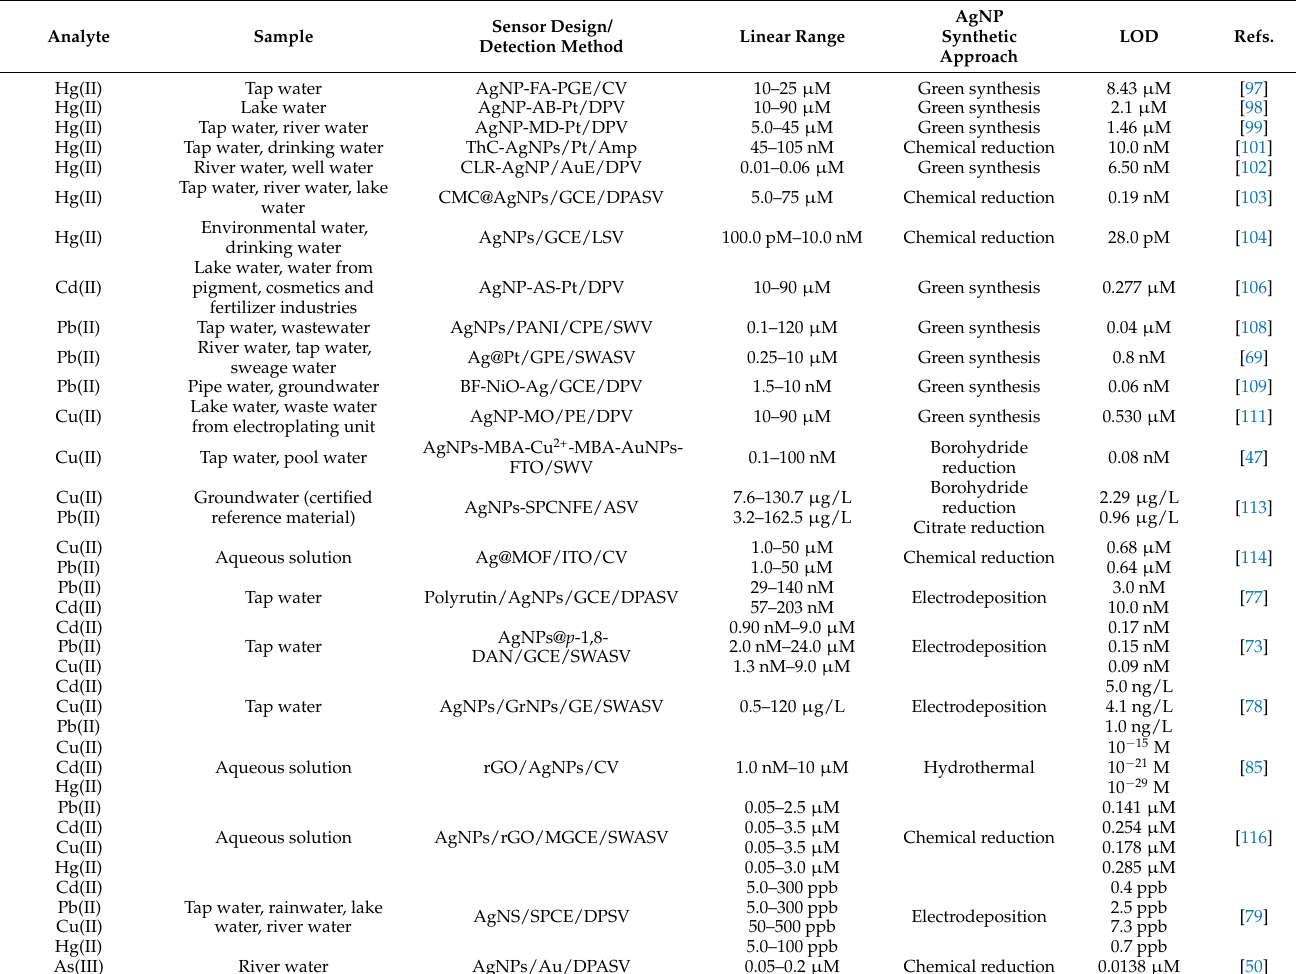
Table 1. Survey of the reviewed silver nanomaterial-based electrochemical sensors for detection of heavy metal ions in water